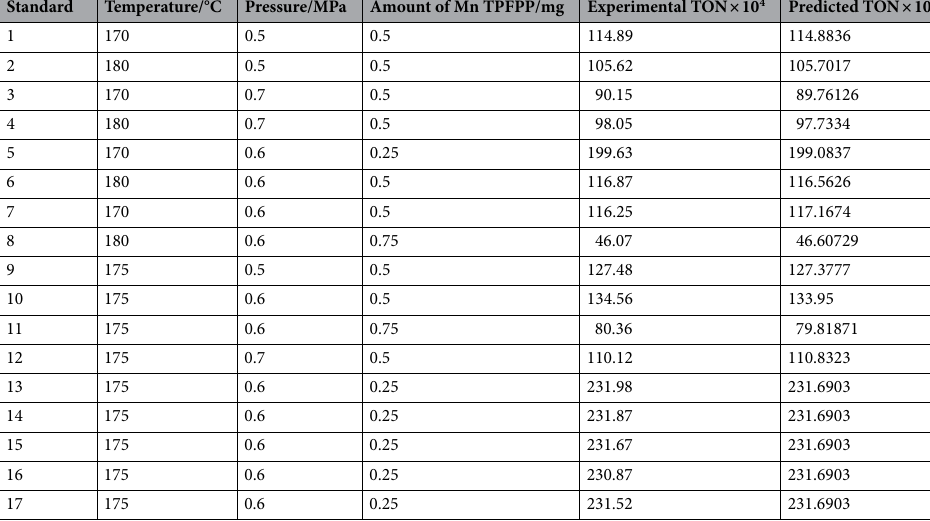
Table 2. Response surface design and experimental